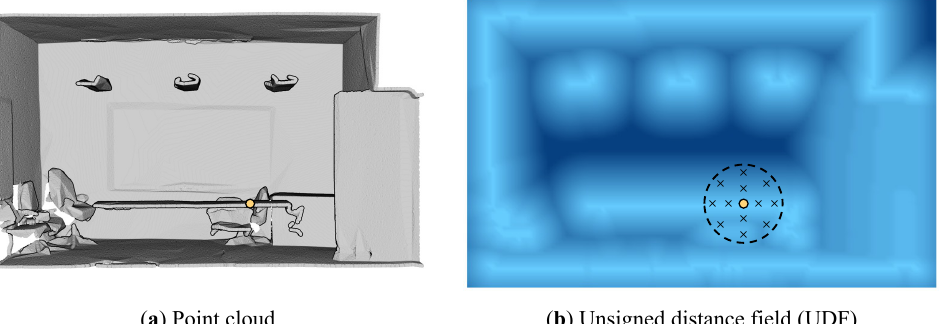
Figure 2. Implementation of implicit feature encoding. For a query point q (yellow dot), the sample sphere is aligned with q and projected to its canonical pose. q ’s implicit feature vector is then obtained by sequentially concatenating the UDF values of each sample position (black cross). The UDF is color-coded from bright to dark in ascending order of the distance values of the